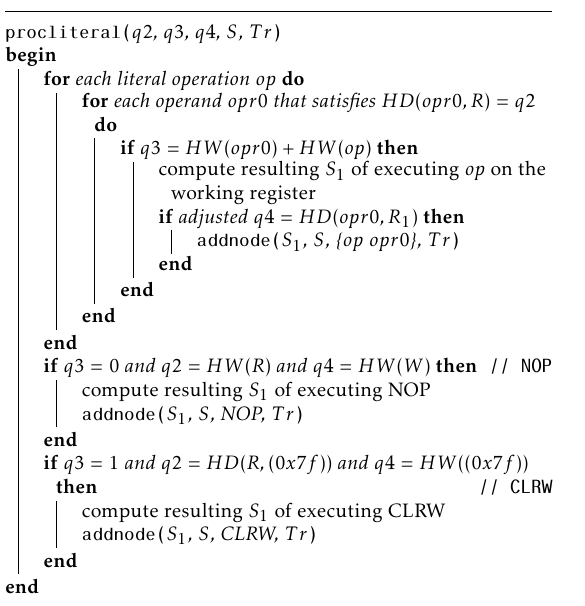
Algorithm 2: procliteral : Find all literal instructions satisfying ( q 2 , q 3 , q 4). Some opti- mizations